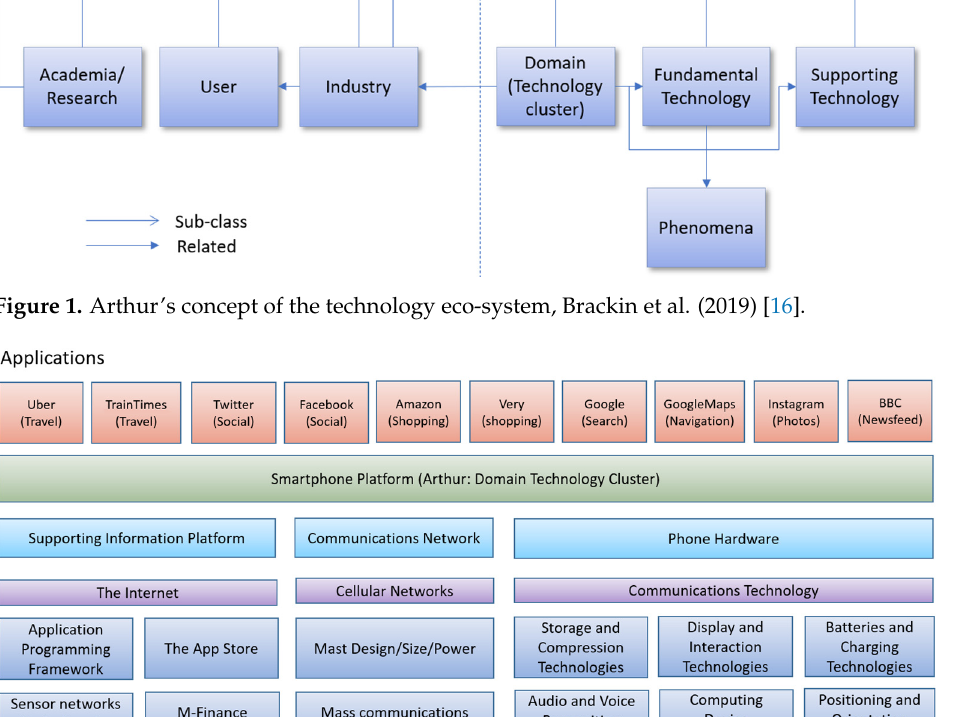
Figure 2. Technologies supporting the smartphone platform.